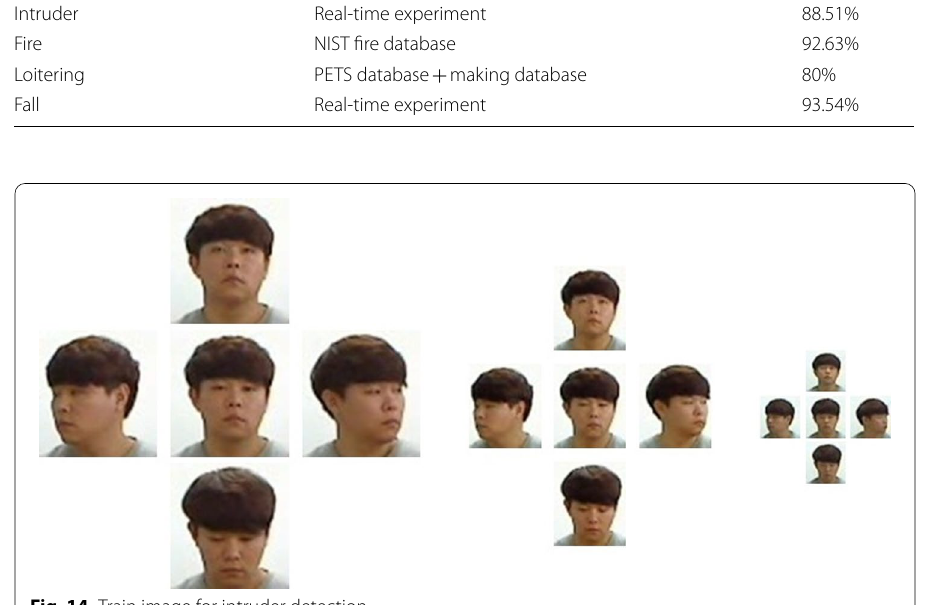
Fig. 14 Train image for intruder